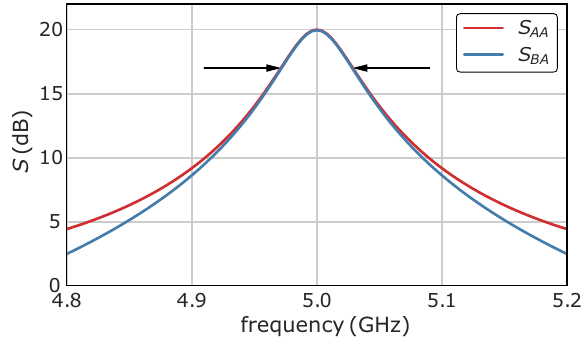
FIG. 4. S parameters of the two-mode parametric amplifier, calculated using the equation-of-motion matrix in Fig. 2(c) and Eq. (8). The frequency axis is referenced to the signal port. Here S AA is the signal reflection gain and S BA is the idler gain. Arrows indicates the 3-dB bandwidth according to Eq.